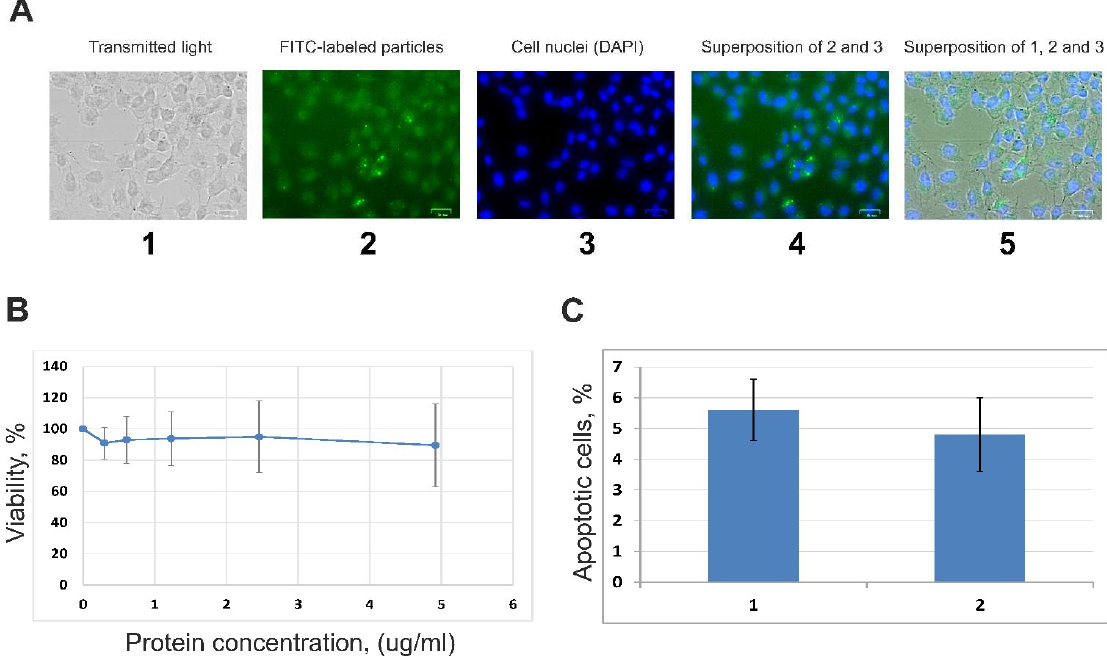
Figure 2. ( A ) Fluorescence microscopy of EVs internalization by human A549 cells. Cells were incubated with FITC-labeled human blood EVs for 24 h. 1—A549 cells in transmitted light; 2—fluorescence of FITC-labeled particles, 3—fluorescence of cell nuclei (DAPI); 4—superposition of 2 and 3; 5—superposition of 1, 2, and 3. Scale bars correspond to 25 μm ( B ). Viability of human lung adenocarcinoma A549 cells incubated in the presence of preparations of blood extracellular vesicles for 48 h (data of MTT-test). The curve corresponds to the change in the MTT index of cells during incubation with different concentrations of EVs. ( C ) Analysis of apoptotic changes in A549 cells under the influence of EVs from human blood by flow cytofluorimetry. The ordinate shows the contribution of cells stained with FITC-Annexin V and PI to the general population of A549 cells. Contribution of the apoptotic cells’ population to the total number of cells incubated for 48 h with (1) or without (2) preparations of blood